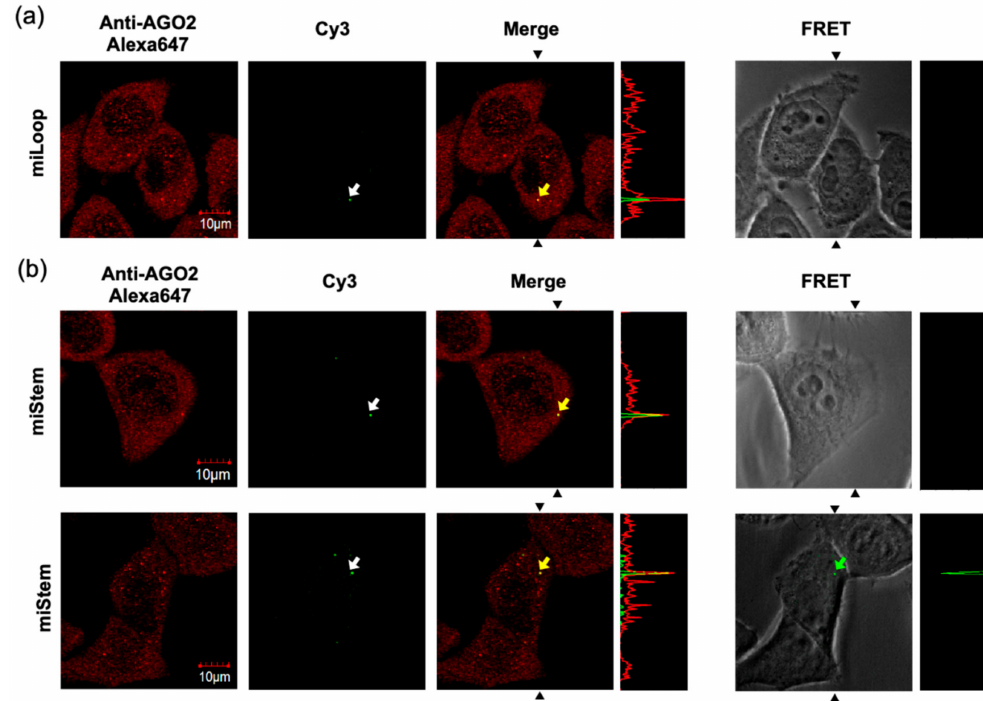
Figure 6. Visualization of the processing intermediates of ( a ) miLoop and ( b ) miStem in the HeLa cells. The fluorescence signals of those that were transfected by the beads loading method were observed by confocal laser microscopy. Endogenous AGO2 was visualized by an anti-AGO2 and Alexa648-conjugated secondary antibodies. The Cy3 and Alexa 647 signals are shown in green and red, respectively. The pictures of the FRET signal were merged with the cell images. The white arrows represent the foci that were detected by the Cy3 signals. The overlays of the red and green images show the co-localization of Cy3 with AGO2, as indicated by the yellow arrows. The foci that were detected by FRET from miStem is represented by the green arrow. The signal strength of the section between the black allows in the pictures are displayed on the right side of each image. The fluorescent signals were recorded as follows: Cy3: Ex = 543 nm, Em = 555–625 nm; Alexa647: